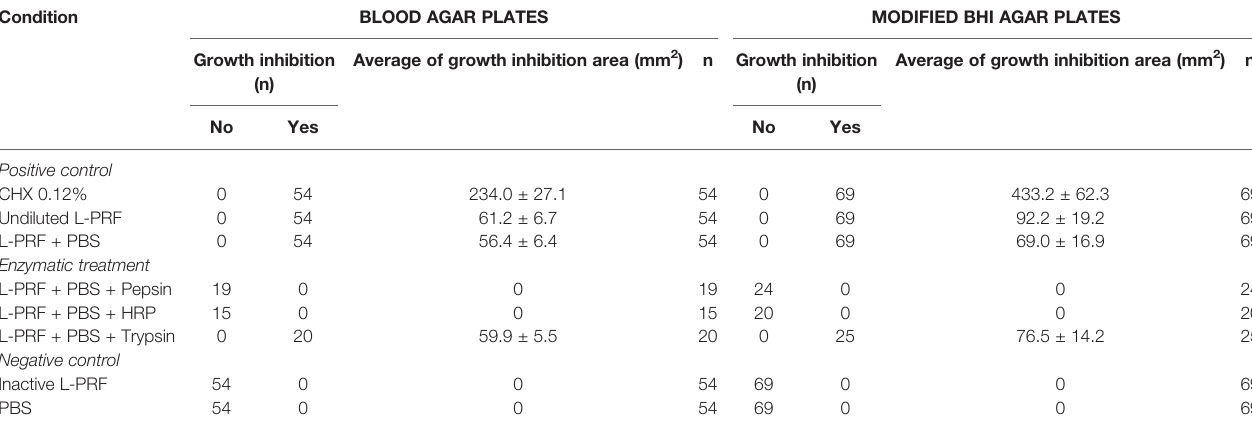
TABLE 1 | Antagonistic experiments on agar plates (mean ± SD).